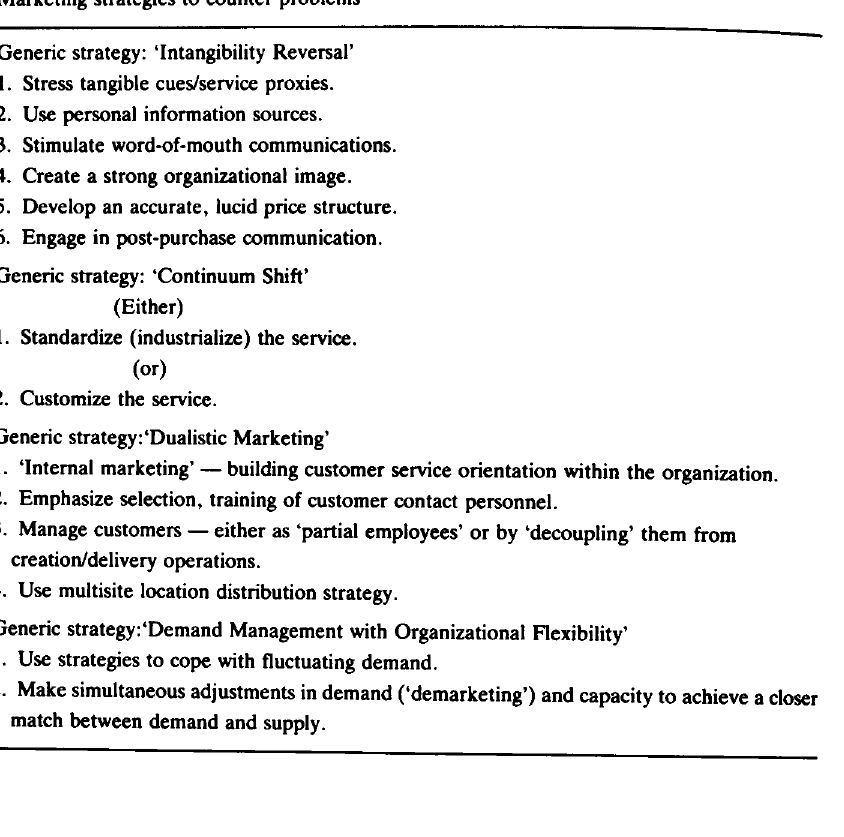
Table 1 Recommended marketing strategies to counter unique service problems Unique service